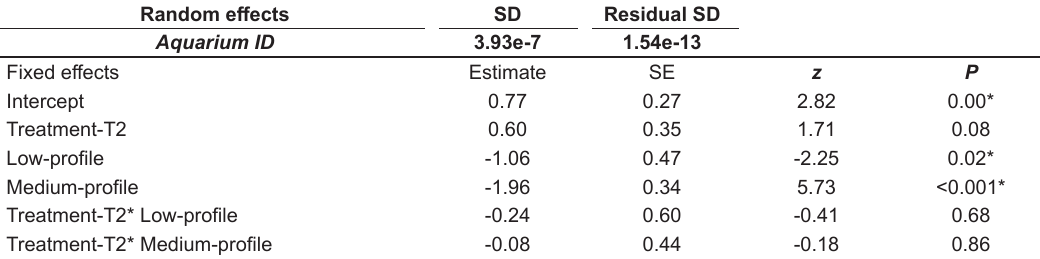
Acta Limnologica Brasiliensia, 2020, vol. 32, e303